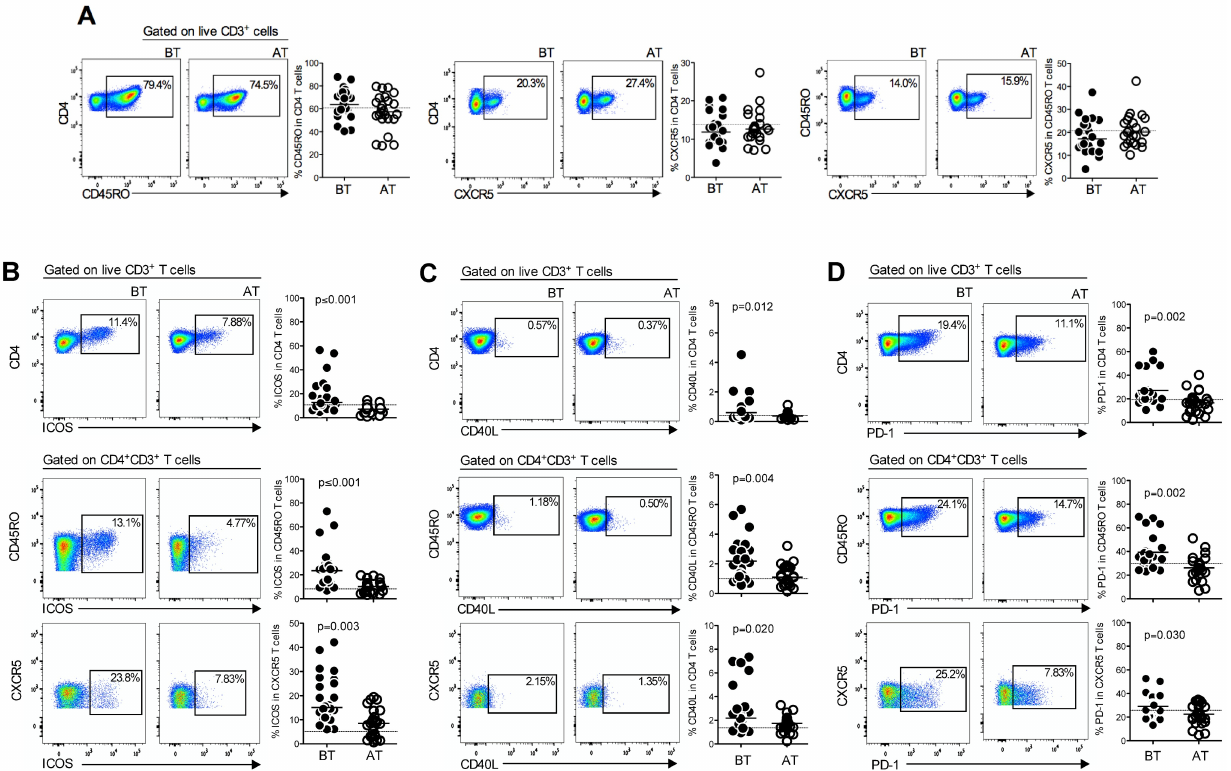
Fig 1. Plasmodium vivax infection triggers the expression of activation markers on CD4 + T, CD45RO + CD4 + T and CXCR5 + CD4 + T cells. PBMC from P . vivax -infected patients were analyzedex vivo (n = 24) duringacute malaria episode(BT, filled circles) and 30–45days after treatment (AT, open circles). All the T cell subsets were analyzedafter gating on live CD3 + cells. A . Representative density plots showing frequency of CD4 + , CD45RO + CD4 + , and CXCR5 + CD45RO + CD4 + T cells (left to right) from a single P . vivax -infected patient. Scattered plots showingthe percentageof CD4 + T cells and CD45RO within CD4 + T cells, and CXCR5 within CD45RO + CD4 + T lymphocytes in P . vivax – infected patients measuredbefore and after treatment (left to right). B-D . Representative density plots showingfrequency of ICOS (B), CD40L (C) and PD-1 (D) expressingCD4 + , CD45RO + CD4 + , and CXCR5 + CD4 + T cells (top to bottom) from a single P . vivax -infected patient (left panels). Frequencyof ICOS (B), CD40L (C) and PD-1 (D) within the T cell subsets described(right panels). Lines represent medianvalues of the given measurement in each group. Dotted lines represent healthy donors. p values are depictedin the